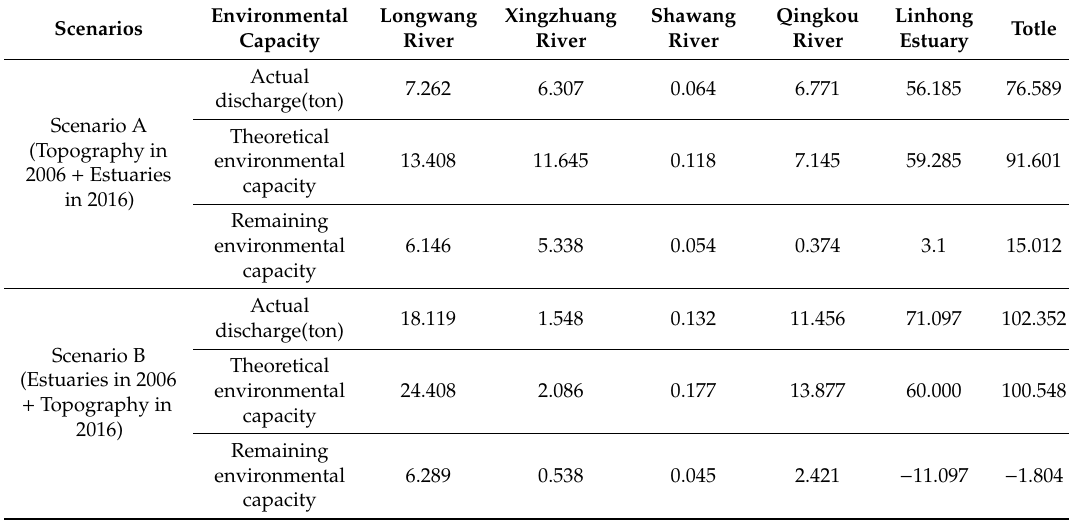
Table 6. The environmental capacity of COD in seawater under t di ff erent calculation boundaries and scenario conditions (Unit: ton).